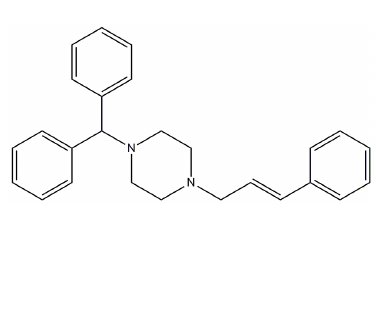
Figure 1. Chemical structure of